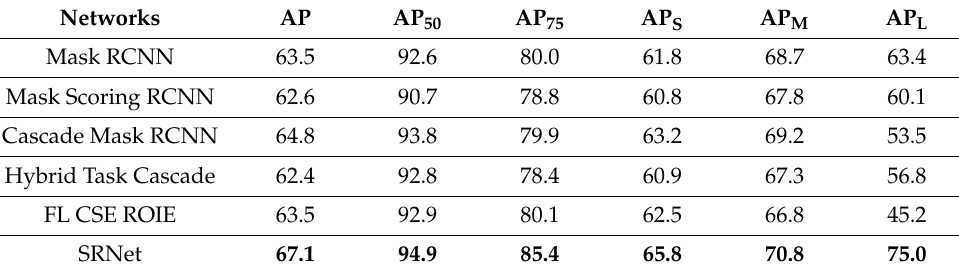
Table 3. Instance-segmentation performance of different networks on the SSDD dataset.